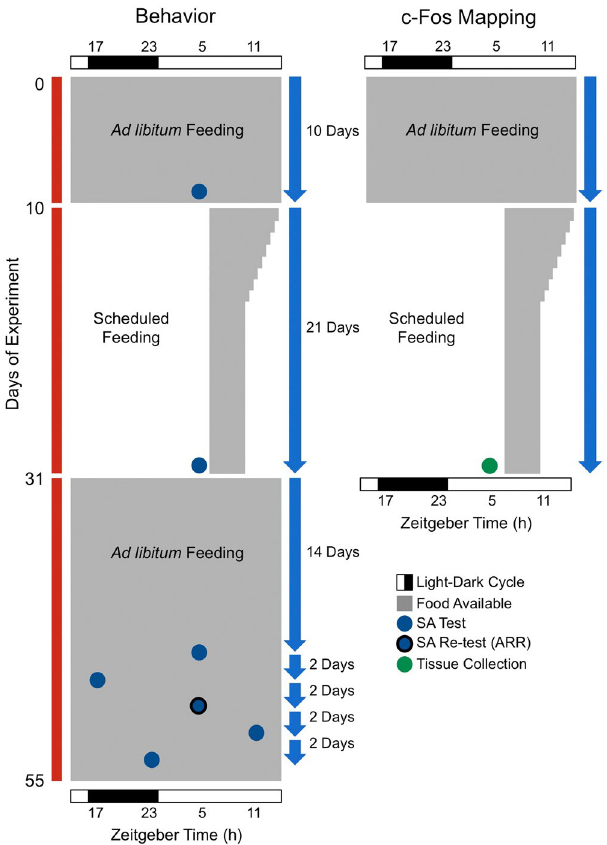
Figure 1. Schematic of behavior (left) and c-Fos (right) experiments. Time of day is indicated by the black and white rectangles. Room lights were on from ZT0-16. Memory tests were performed at four zeitgeber times (ZT; 17, 23, 5, 11). ZT17 and 23 indicate early and late night, respectively. The timeline for the project runs from top to bottom (red). The number of days for each section of the study is indicated by arrows (blue). The periods of scheduled feeding (SF) and ad libitum feeding are shaded in gray. SF began at ZT5 and was 8 h long on the first day, and then decreased by 30 min on successive days until it was 4 h in duration. SF lasted 21 days. The days on which memory was tested, as well as the times of day testing occurred, are indicated by filled circles (blue). Those blue circles show that memory was tested in the same group of animals at multiple time points with 2 days in between each test. Memory was tested twice at ZT5 in DPS-arrhythmic (ARR) animals as indicated by the blue circle outlined in black. The day and time of tissue collection for c-Fos studies is indicated by a filled circle